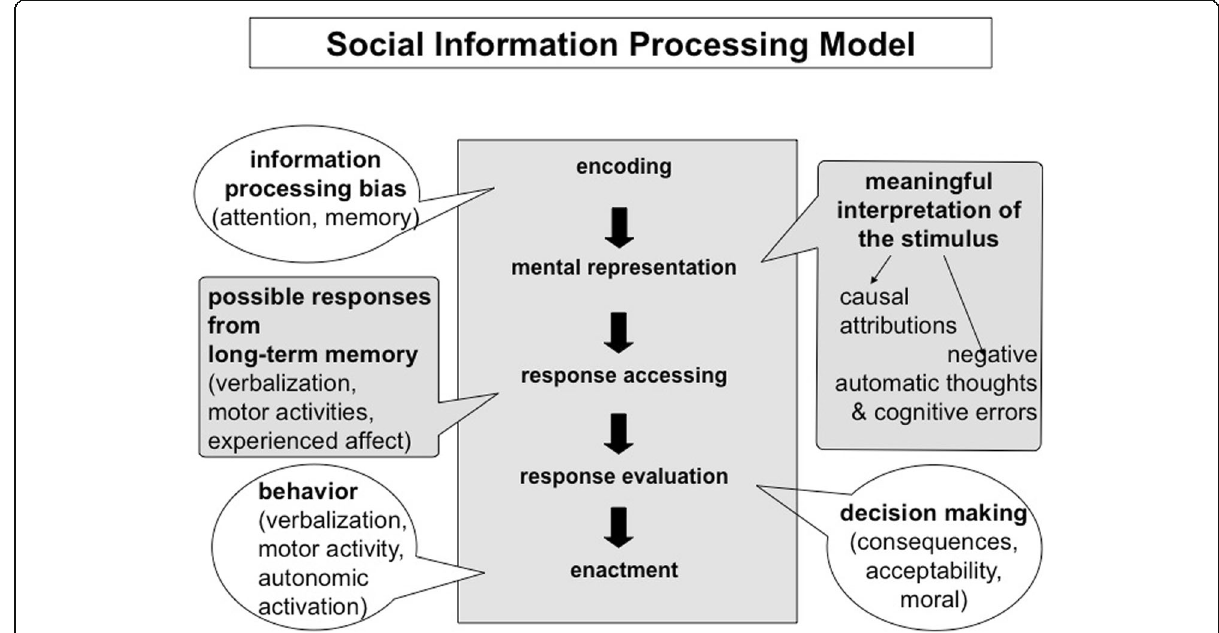
Fig. 1 Dodge ’ s Social Information Processing Model